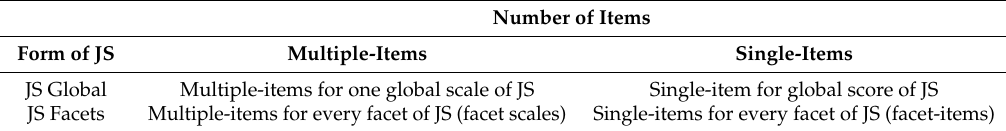
Table 1. Different forms of measurement of assessing job satisfaction